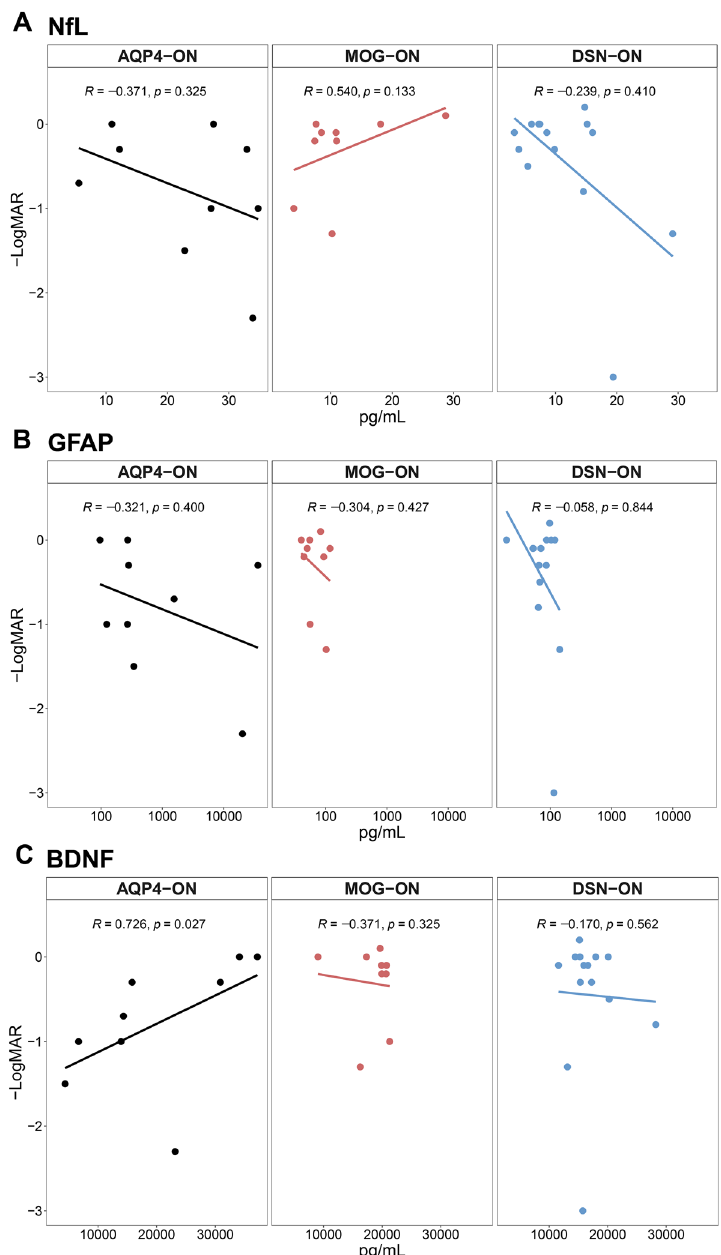
Figure 4. Correlation analyses between visual acuity at remission state and baseline serum biomarkers in patients with AQP4-ON, MOG-ON, and DSN-ON. Correlation between visual acuity (− Logarithm of the Minimum Angle of Resolution) at follow-up (remission state) and serum biomarkers levels at baseline (attack state) for ( A ) NfL, ( B ) GFAP, and ( C ) BDNF in patients with ON. AQP4-ON optic neuritis with aquaporin-4 antibody, BNDF brain-derived natriuretic factor, DSN-ON double-seronegative optic neuritis, GFAP glial fibrillary acidic protein, MOG-ON optic neuritis with myelin oligodendrocyte glycoprotein antibody, NfL neurofilament light chain, ON optic